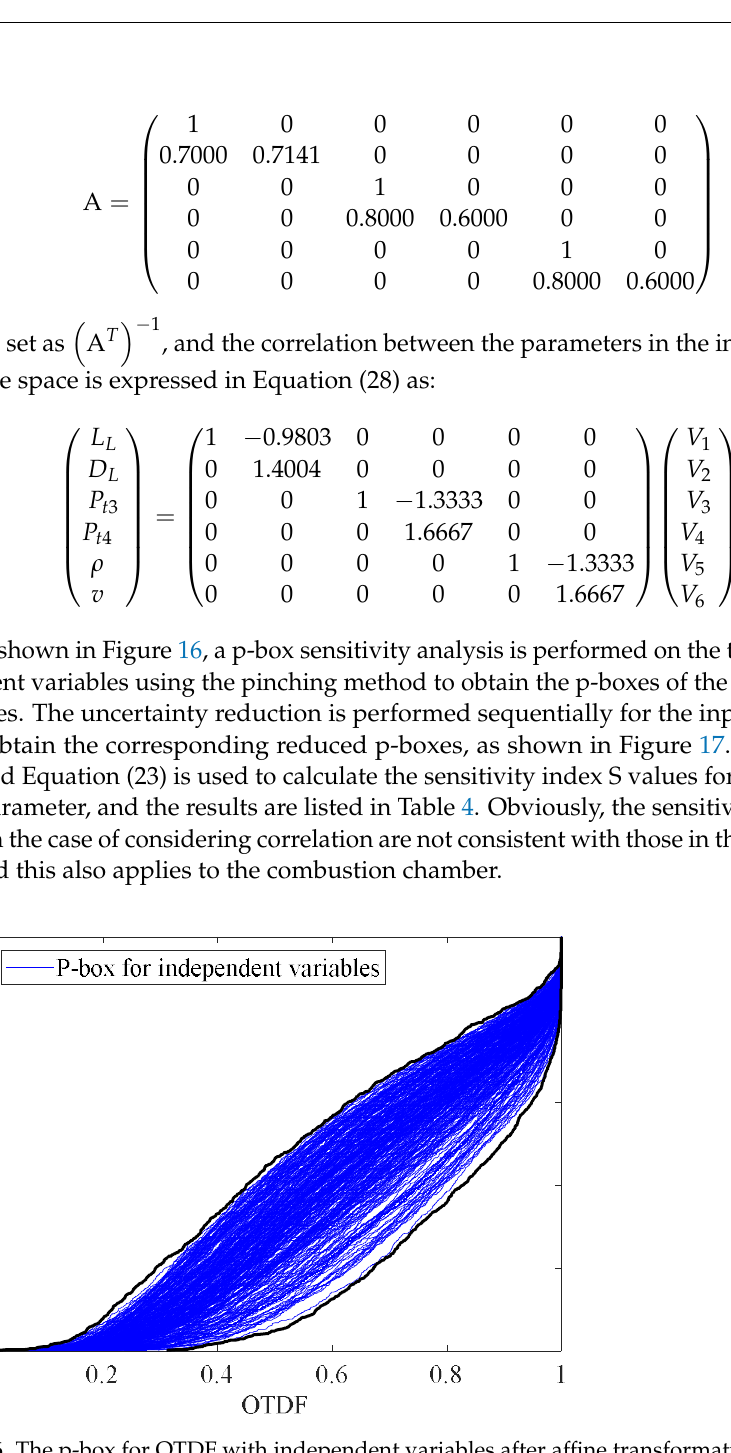
Figure 17. P−boxes for OTDF with diverse independent inputs pinched. 6. Conclusions A systematic analysis process for the preliminary design stage of an aero-engine an- nular combustion chamber is proposed in this study, using a multi-dimensional parallel- epiped model to address the problem of variable coupling. The uncertainty propagation